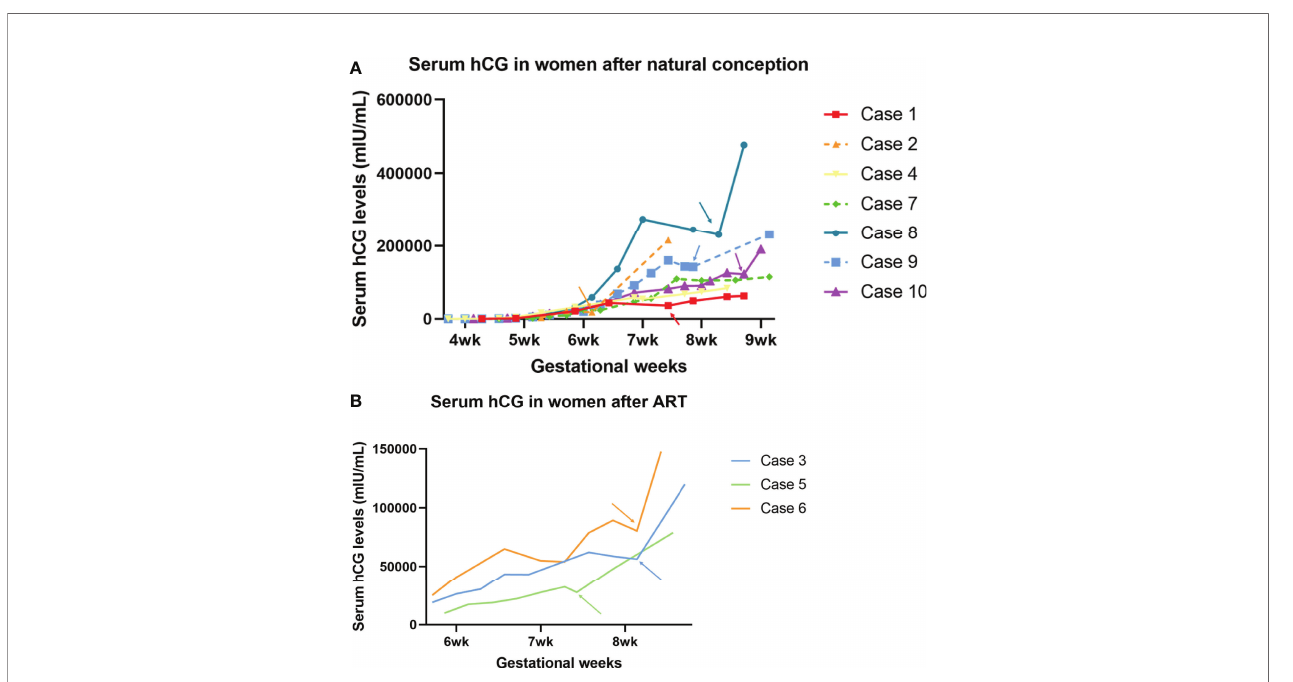
FIGURE 1 | Serum hCG trajectory of each of the ten cases. The generated curve of serial hCG values of women who present early decline in the fi rst trimester in the current pregnancies. (A) The subgroup of women following natural conception (n=7). (B) Subgroup of women following ART (n=3). Arrows with corresponding colors indicate the timing of administration of